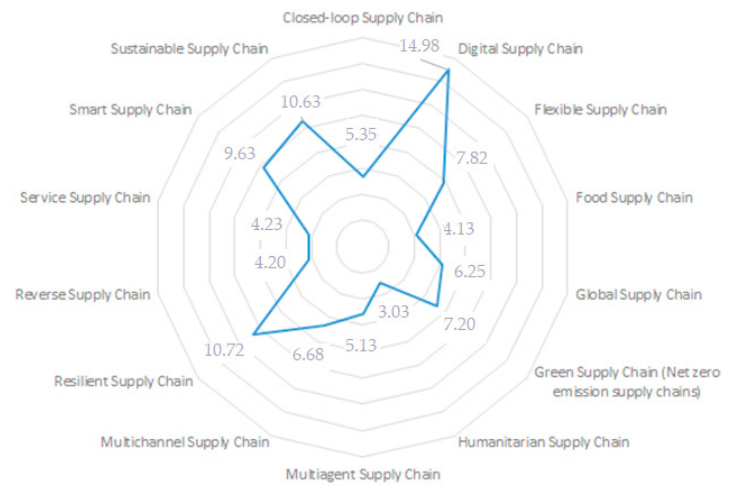
Figure 10. Mean ranking values of global theoretical trends and supply chain development direc- tions in the context of the dynamic development of technology and production organization (Indus-